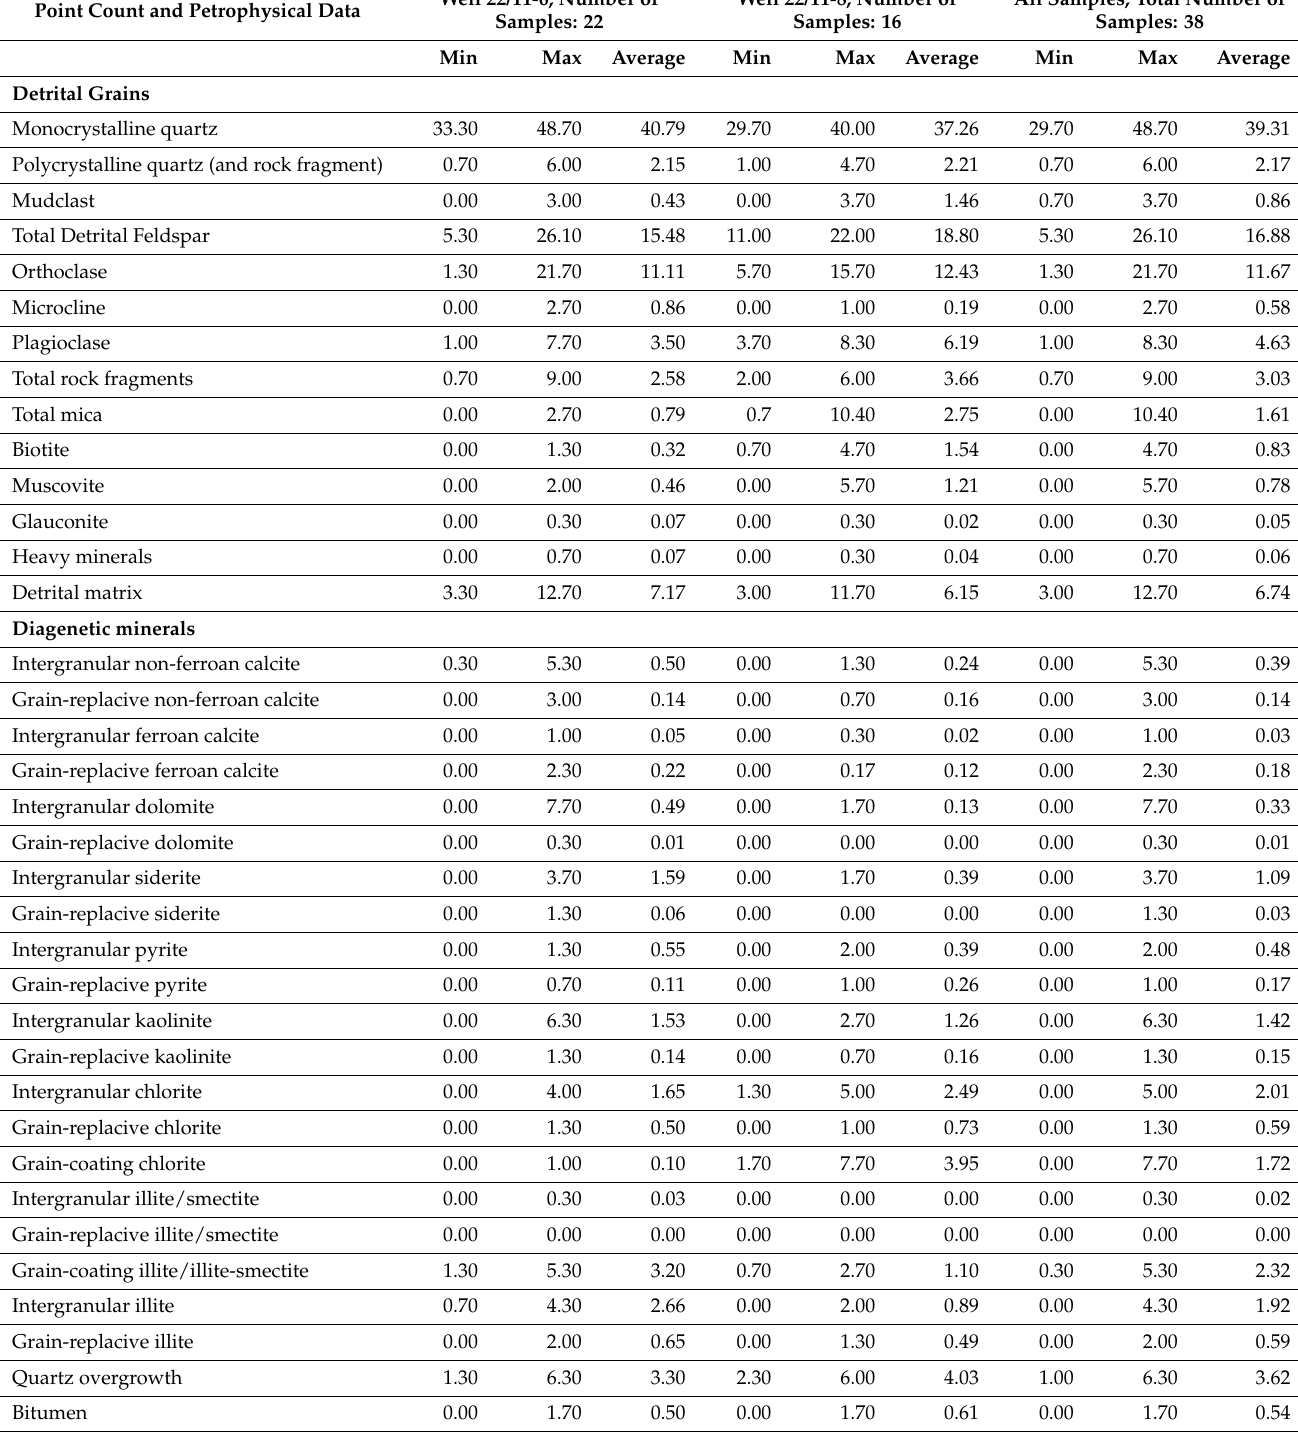
Table 1. Statistical summary of petrographic and petrophysical parameters of the Forties Sandstone